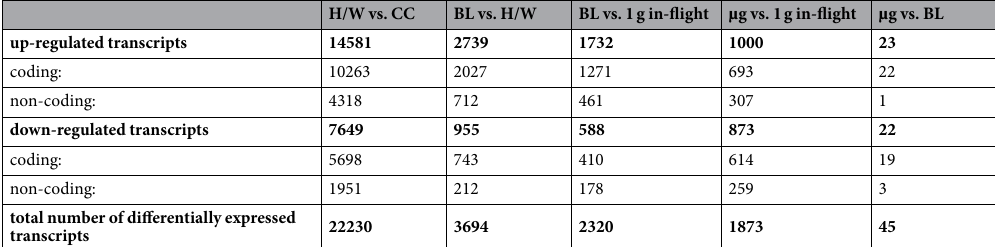
Fig. 9 and Table 9, 13 genes are displayed that were differentially expressed in both microgravity and hypergravity during the TEXUS experiment. Among these genes, we found kinase activators important for the GPCR signa- ling, as well as a gene involved in Wnt signaling, a gene that is important for the nucleocytoplasmatic transport, two transcription factors, a gene that is involved in rRNA processing, and two tumor suppressor genes, and a cell